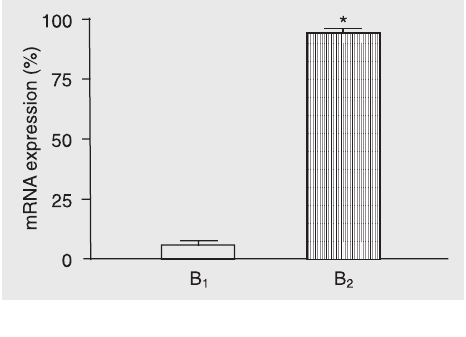
Figure 4. Effect of indomethacin on the effect of bradykinin (BK) and Des-Arg 9 BK (DBK) in preparations of aortic rings. Cu- mulative concentration-re- sponse curves for BK (A) and DBK (B) were obtained in the absence and in the presence of 1 µM indomethacin, a cyclooxy- genase inhibitor. Percent con- traction was calculated from the steady-state tension induced by norepinephrine (NE). Data are reported as the means ± SD of 4 experiments. *P < 0.05 com- pared to control (ANOVA).